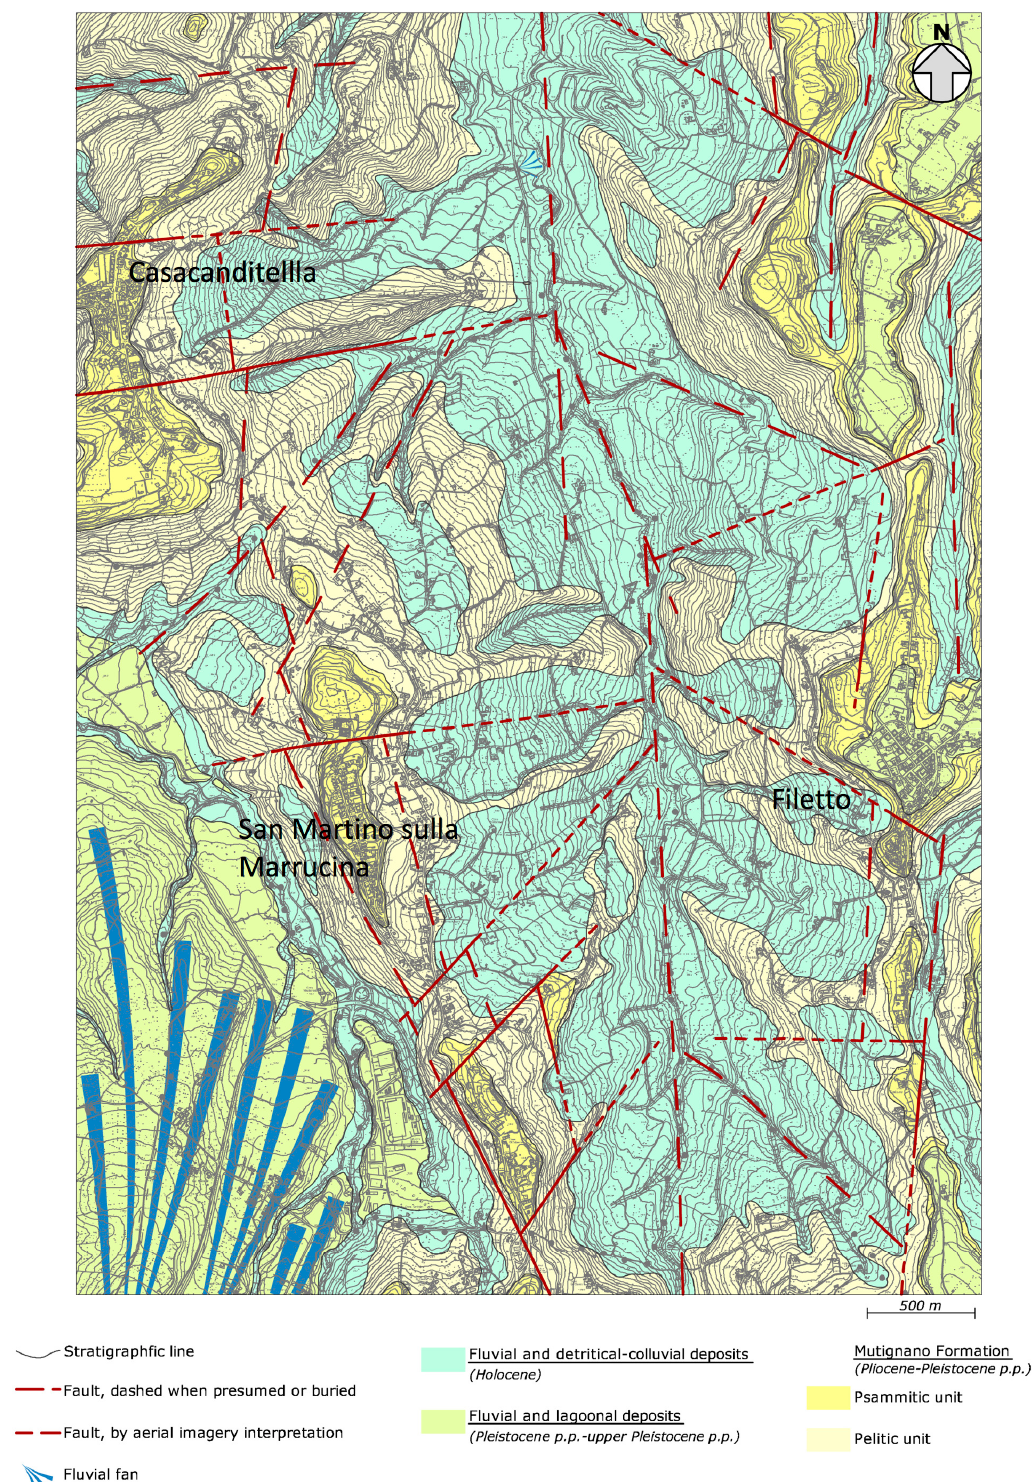
Figure 2. Geological map of the study area produced by the authors.